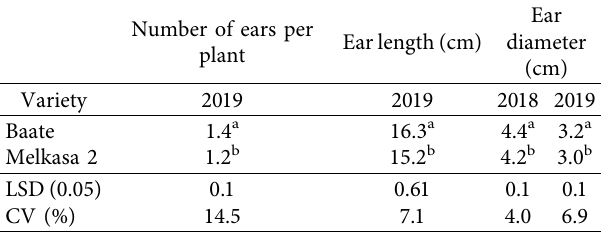
Table 6: The number of ears per plant, ear length, and ear diameter as affected by the main effect of variety in the 2018 and 2019 cropping